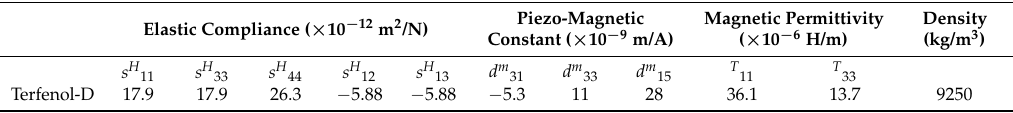
Table 1. Material properties of Terfenol-D